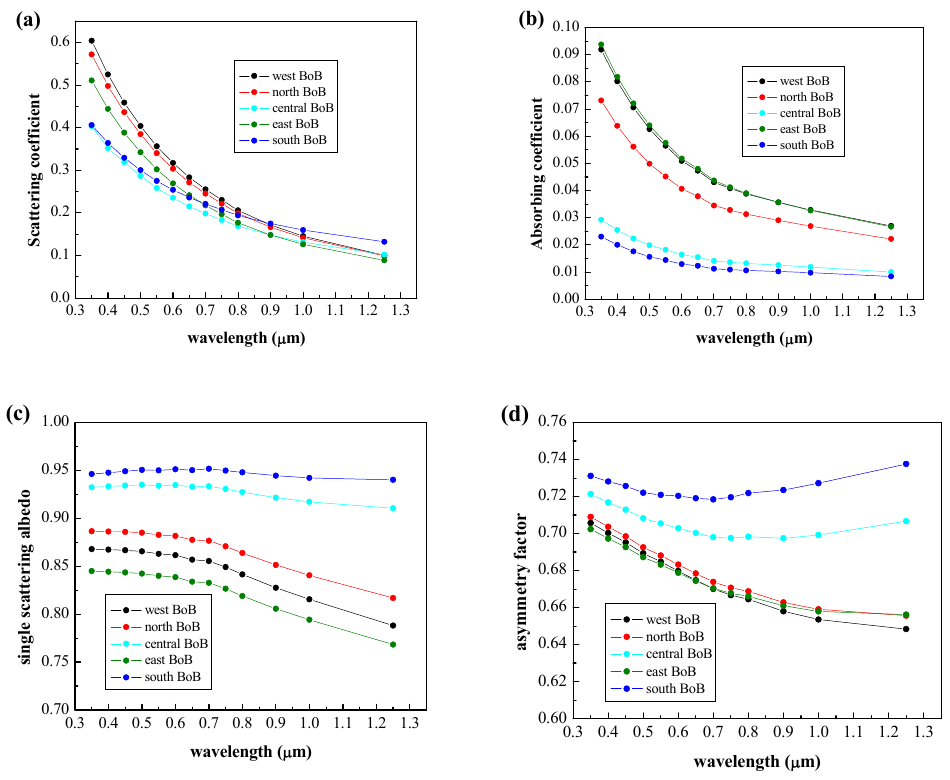
Fig. 15. Spectral variation of the scattering coefficient (a) , absorption coefficient (b) , single scattering albedo (c) and asymmetry factor (d) over the 5 BoB sub-regions obtained via OPAC